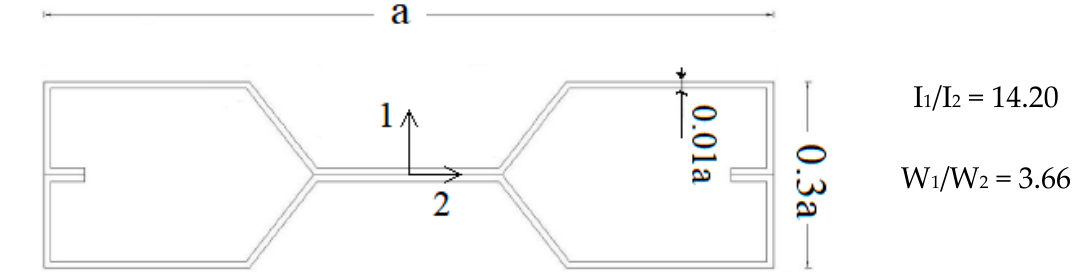
Figure 5. Column cross-section of the considered cheese rack.